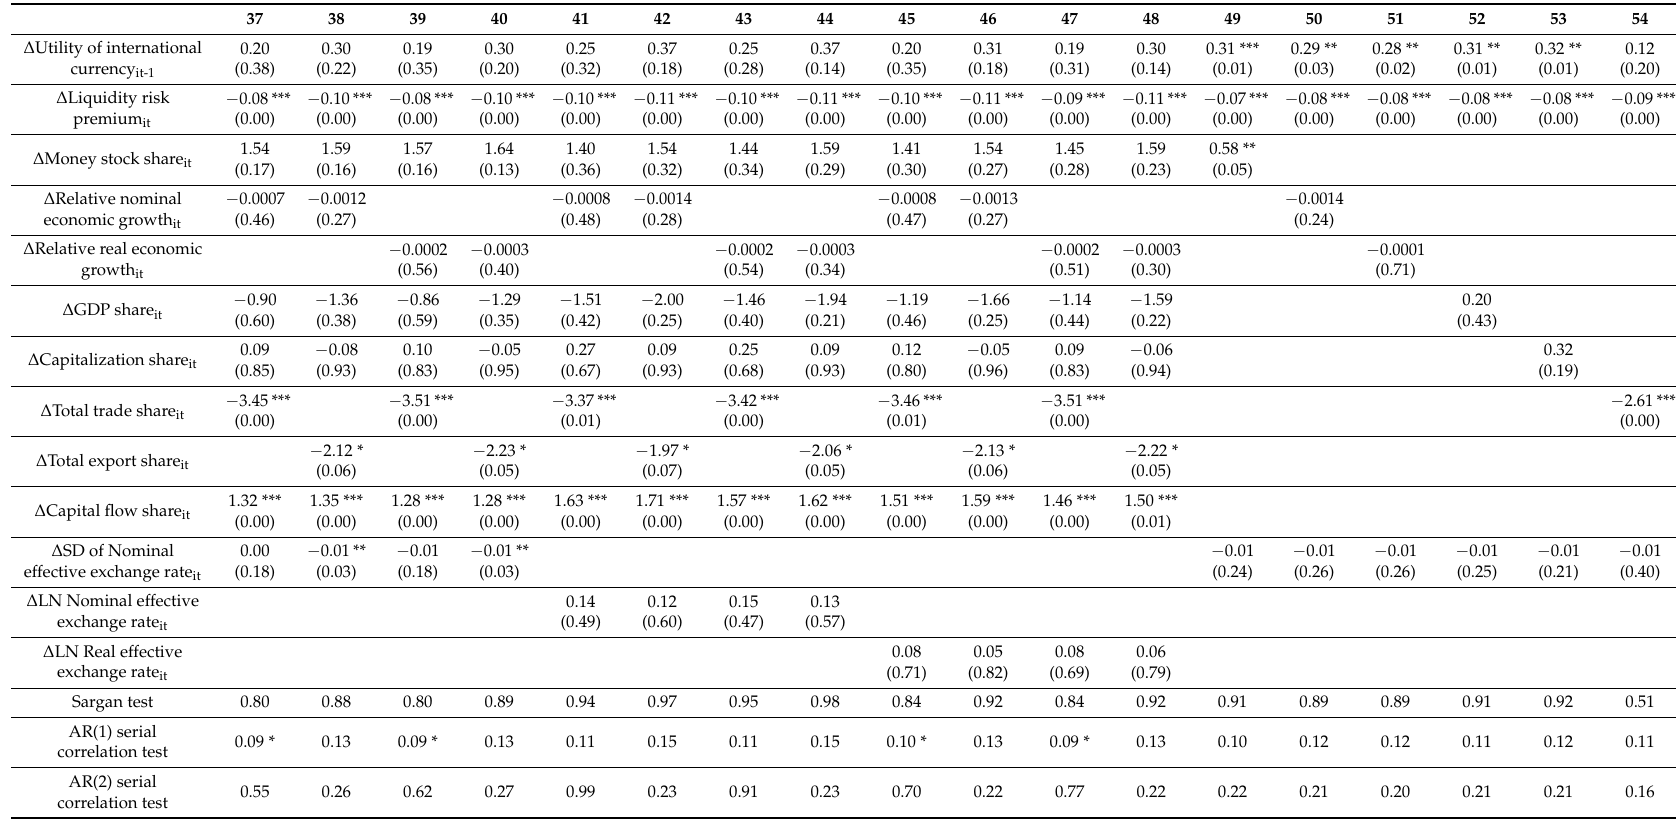
Table 3. Determinants utility of international currency (real interest rate